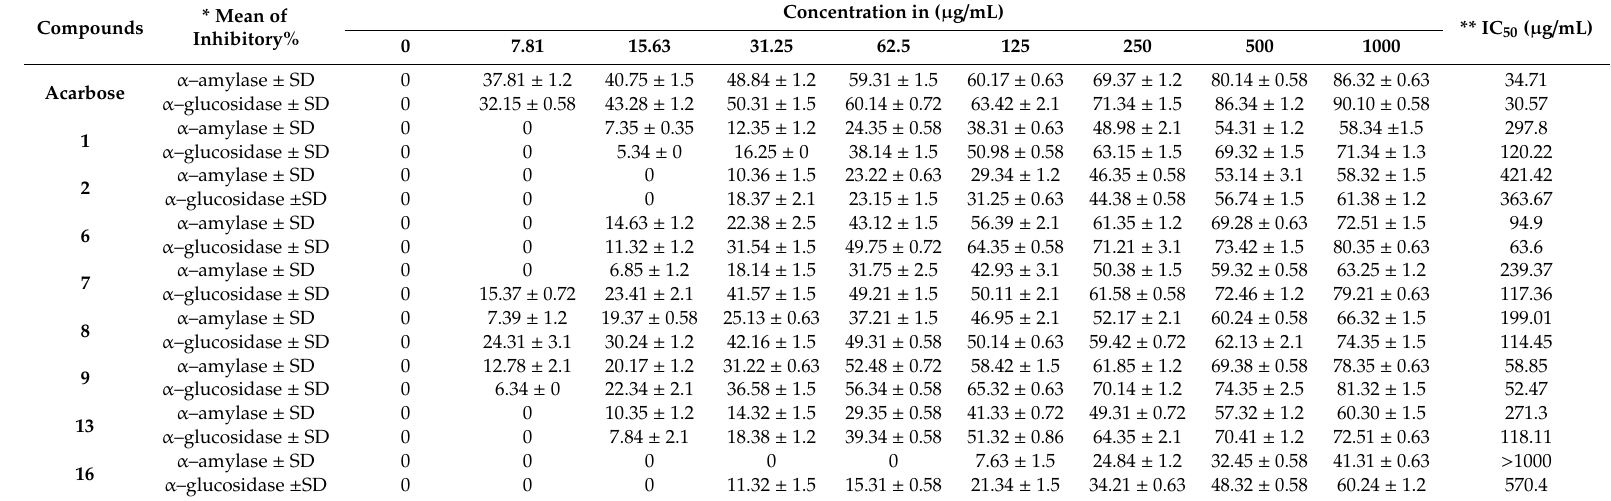
Table 2. E ff ect of treatment at various concentrations of prepared compounds on alpha-amylase inhibitor and alpha-glucosidase inhibitor.